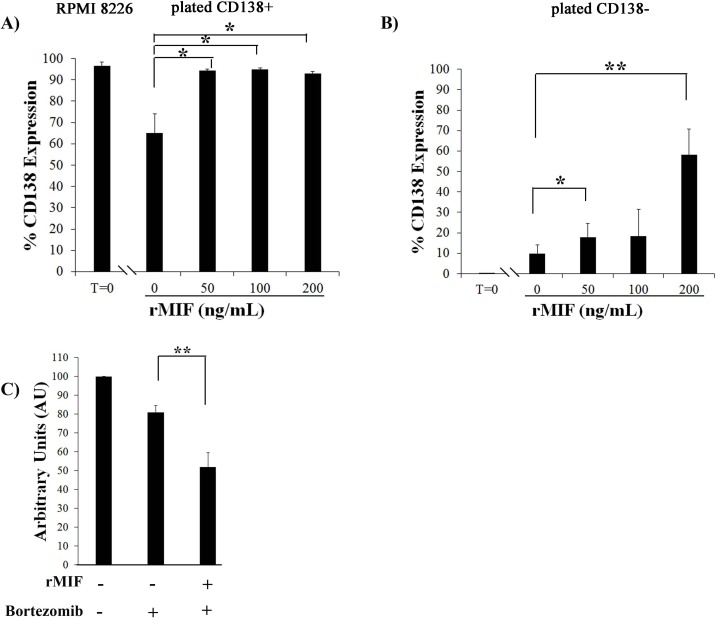
rMIF promotes the differentiation and maintenance of RPMI 8226 CD138+ cells.A) Sorted CD138+ and B) CD138- cells were plated, treated with increasing concentrations of rMIF for 24 h. Cells were stained with CD138 and PI and the CD138 content of viable (PI negative) cells is plotted (N = 3). T = 0 is CD138 content at time of plating. C) Sorted CD138- cells were plated and untreated (lane 1), treated with Bortezomib. (lane 2), or treated + rMIF and Bortezomib for 24 h (lane 3). The MTT assay used to assess viability of the different populations, mean absorbance values of untreated cells (lane 1) was set to 100 (N = 3). **p<0.001 t-test with Satterthwaite corrections to allow for possible unequal variances. Error bars, mean ± SD.